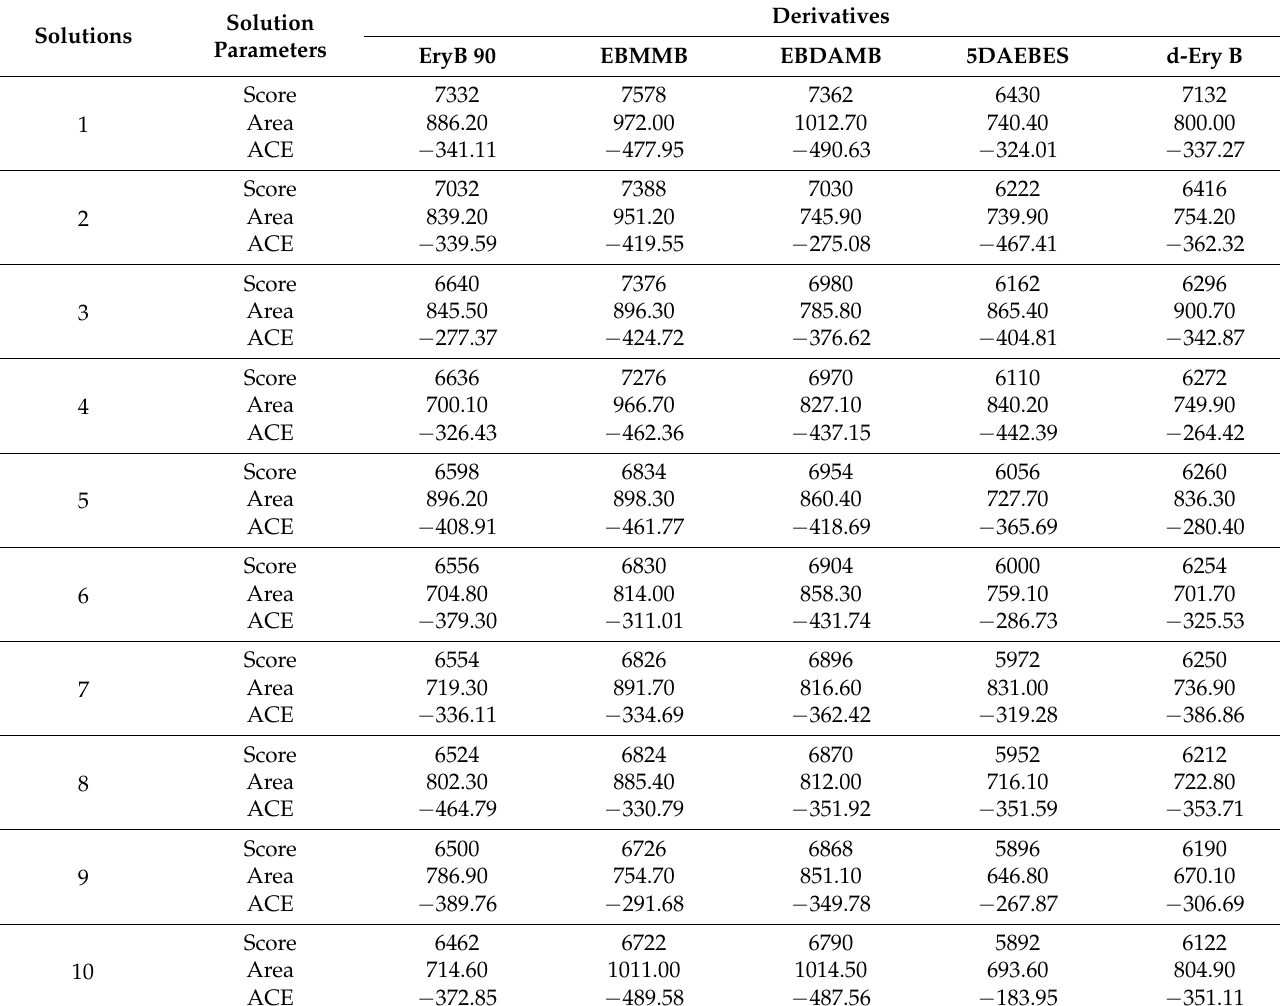
Table 2. Score, area, and ACE (atomic contact energy) of top ten results based on shape complementarity principles for docking analysis of investigated derivatives of erythromycin B with complex of protein and three domains of 23S